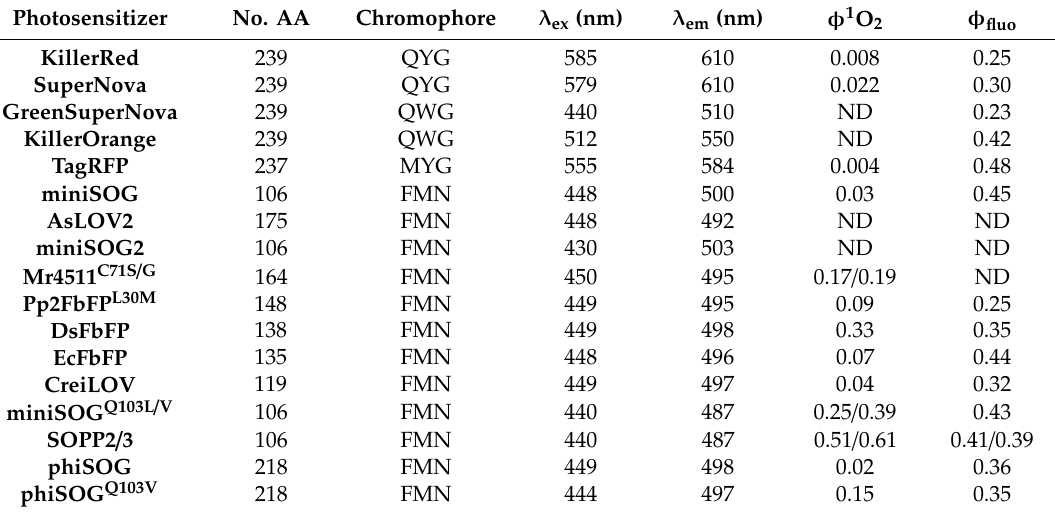
Table A1. Genetically encoded protein photosensitizers (GEPP).